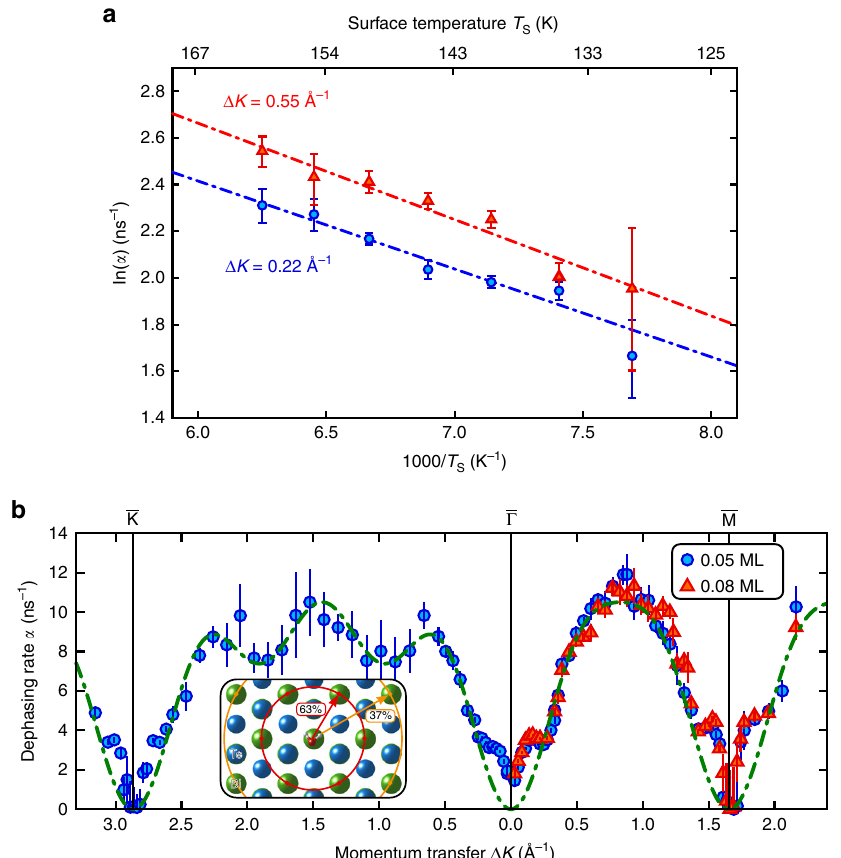
Fig. 2 Dephasing rates α ð Δ K Þ as determined from measurements of I ð Δ K ; t Þ . a Arrhenius plot showing the temperature dependence at two different momentum transfers along the Γ M -azimuth for the diffusion of water on Bi 2 Te 3 (111). The measurements were taken at an H 2 O coverage of 0.05 ML. b Momentum transfer dependence for the diffusion of H 2 O on Bi 2 Te 3 (111) at a fi xed temperature. The measurements were taken at a constant surface temperature of T S ¼ 150 K and a water coverage of 0.05 ML (blue circles) and 0.08 ML (red triangles), respectively. The dash-dotted line corresponds to the analytic model for jump-diffusion with jumps on a hexagonal lattice to nearest and next-nearest sites as illustrated in the small inset. The red and yellow circles illustrate the jump distance to the next and next nearest sites, respectively. The extracted barriers E a and pre-exponential factors α 0 for two different momentum transfers Δ K as well as the pre-exponential hopping rate Γ 0 for the diffusion process at 150 K are given in Table 1. The error bars correspond to the con fi dence bounds (1 σ ) upon determination of α ð Δ K Þ from the measurements of I ð Δ K ; t Þ — see text.